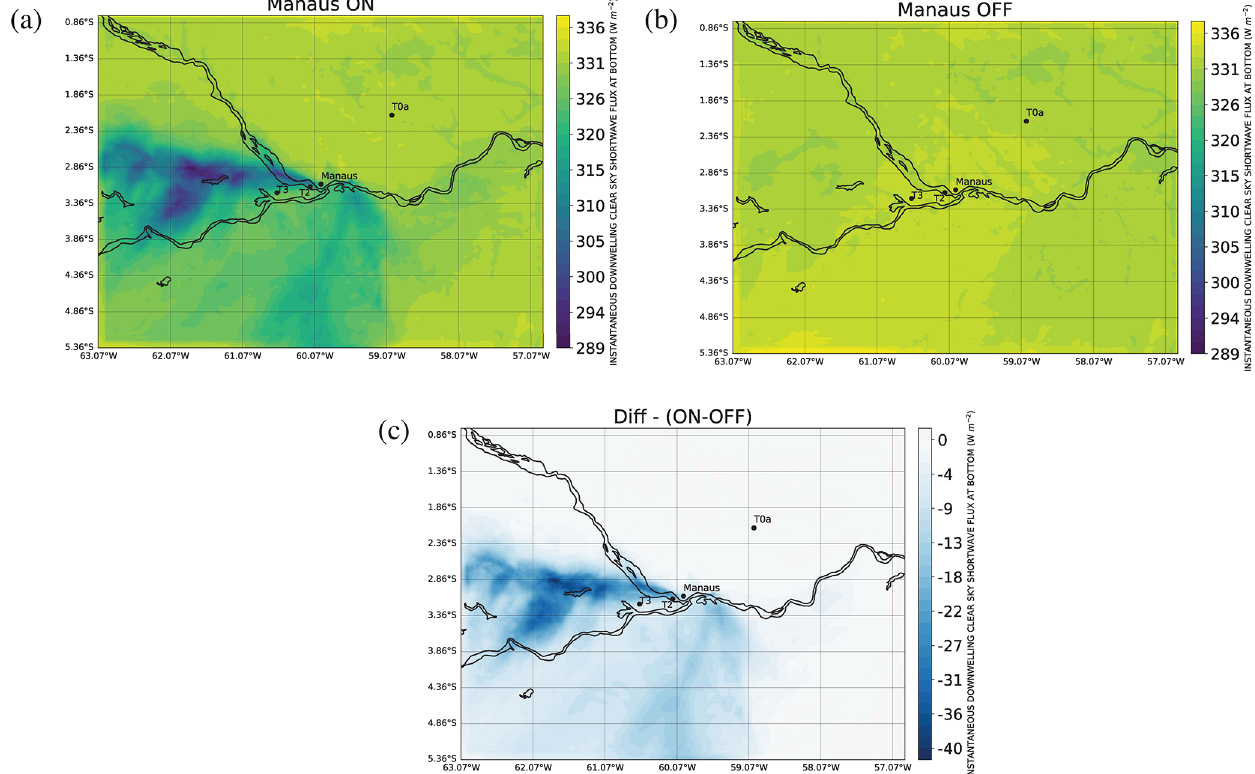
Figure 10. WRF-Chem-simulated mean incoming solar radiation (instantaneous downwelling clear-sky shortwave flux at the bottom – SWDNBC), in watts per square meter, in the presence and absence of Manaus emissions. (a) SWDNBC, when all emissions are on. (b) SWDNBC, when biogenic emissions are on and anthropogenic emissions are off. (c) SWDNBC difference between the simulations, with and without anthropogenic emissions, i.e., ON −